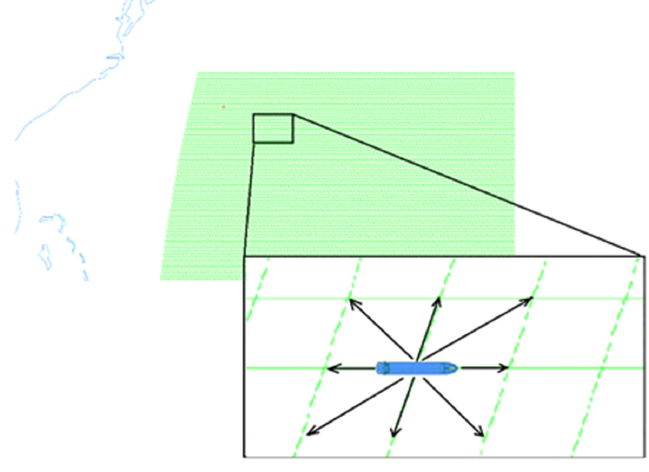
Figure 4. Overview on the matrix elements.